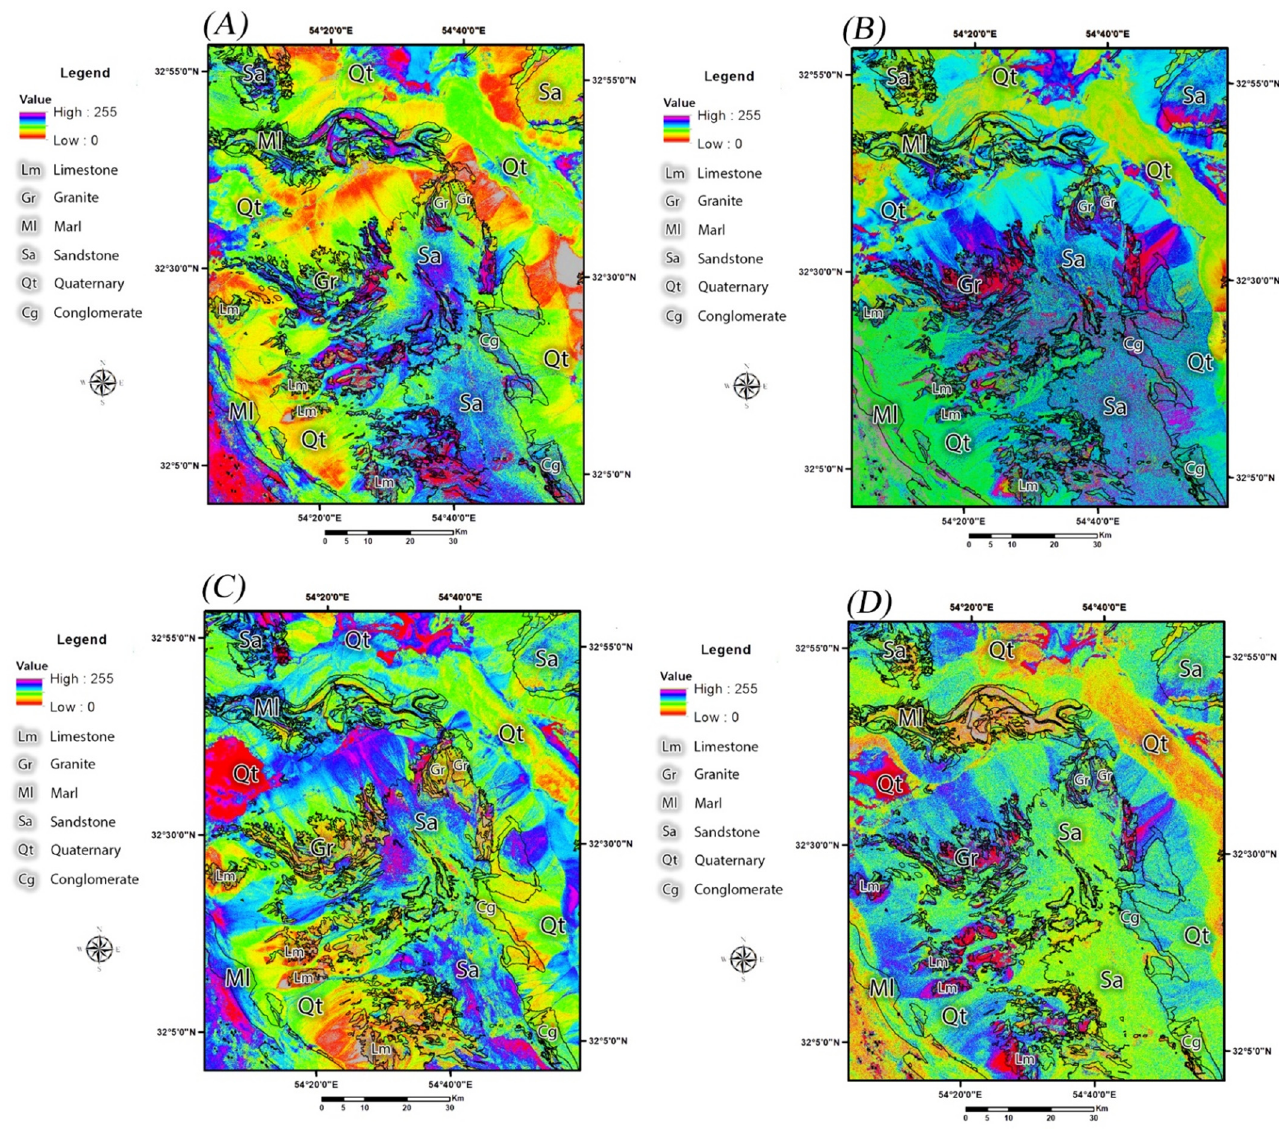
Figure 5. Spatial distribution of iron oxide/hydroxides and hydroxyl-bearing (Al-OH) alteration and carbonates in the study area as pseudo-color ramp. ( A ) PCA2 image of Sentinel-2; ( B ) PCA4 image of Sentinel-2; ( C ) PCA3 image of Landsat-7; ( D ) PCA4 image of Landsat-7.